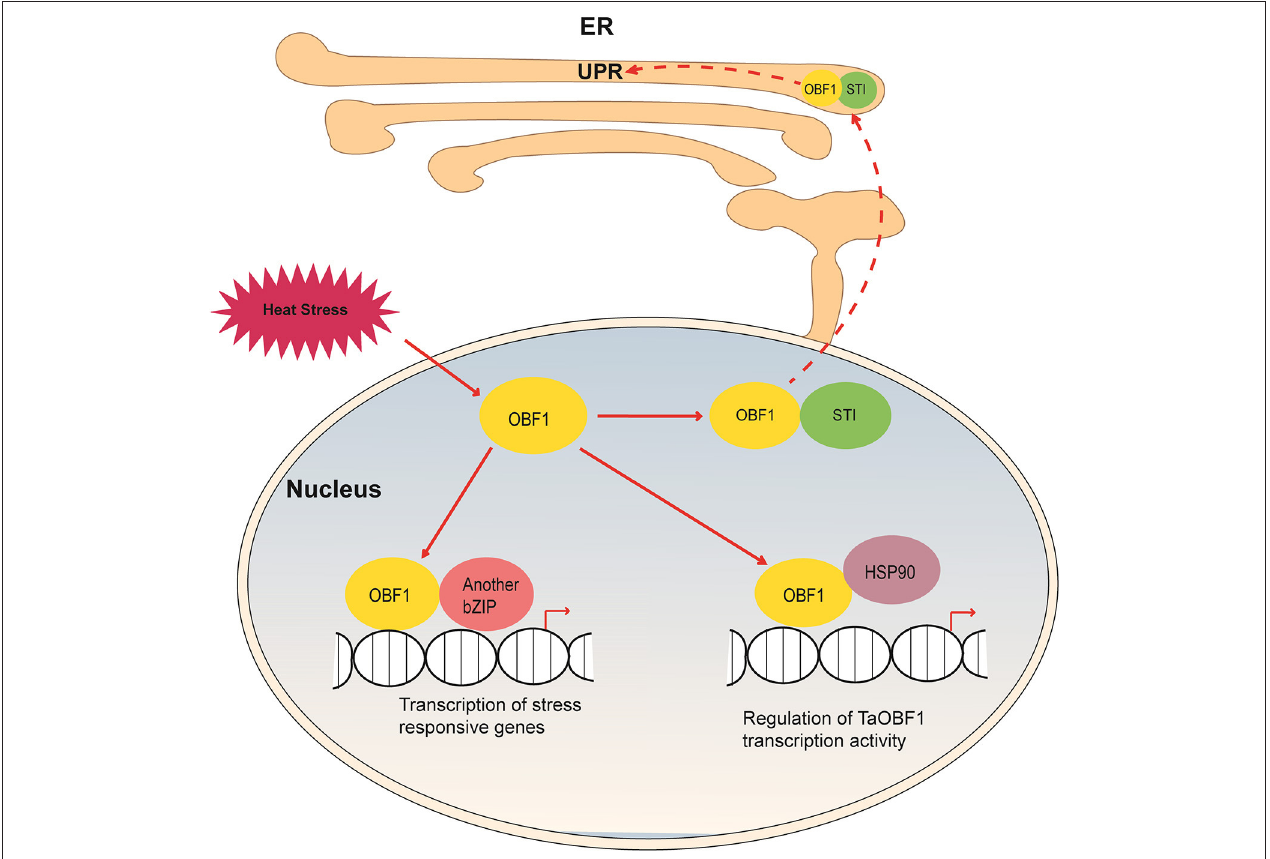
FIGURE 11 | Hypothetical model depicting the role of TaOBF1 in heat stress response. Upon heat stress, TaOBF1 by interacting with TaHSP90 translocates from nucleus to the ER where it participates in the protein unfolding response. Also inside the nucleus, it forms homodimers and heterodimers (by interaction with other bZIPs) and regulates the transcription of heat stress-responsive genes, which aid in providing thermotolerance. Apart from this, TaHSP90 also interacts with TaOBF1 and regulates its transcriptional